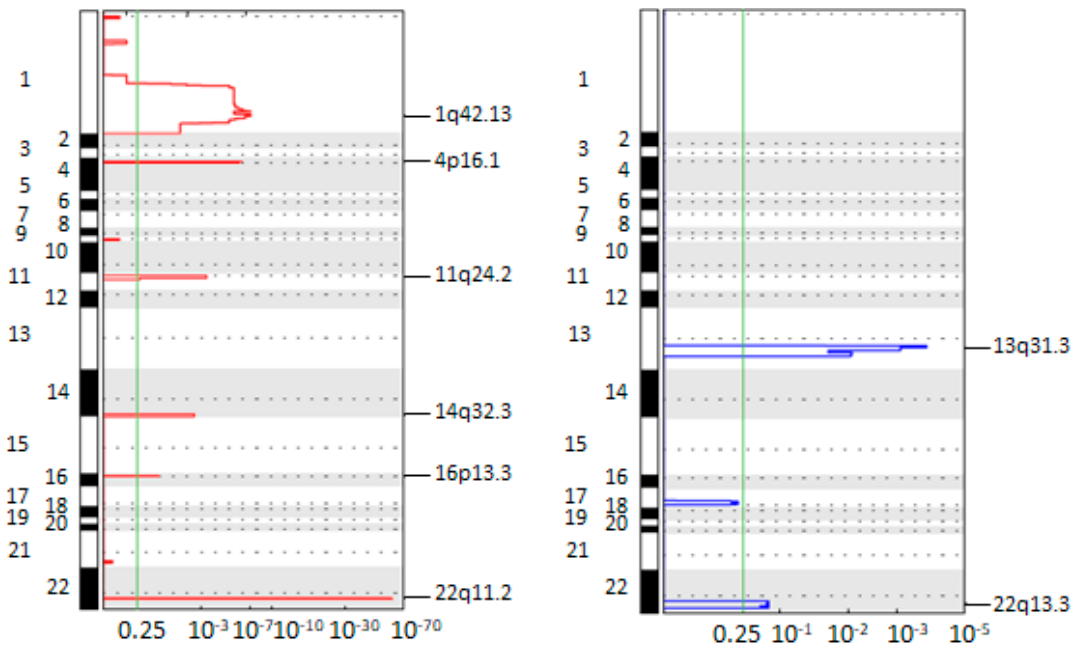
Figure 1. Genomic Identification of Significant Targets in Cancer (GISTIC) amplification (left, red) and deletion (right, blue) plots on single circulating tumor cells (CTCs) of all the patients. The genome is oriented vertically from top to bottom, and the GISTIC q-values at each locus are plotted from left to right on a log scale. The green line represents the significance threshold ( q -value = 0.25).